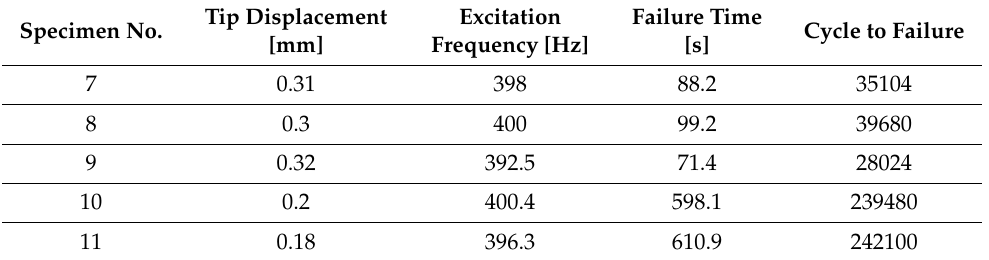
Table 6. Endurance test results for the FCC specimen.